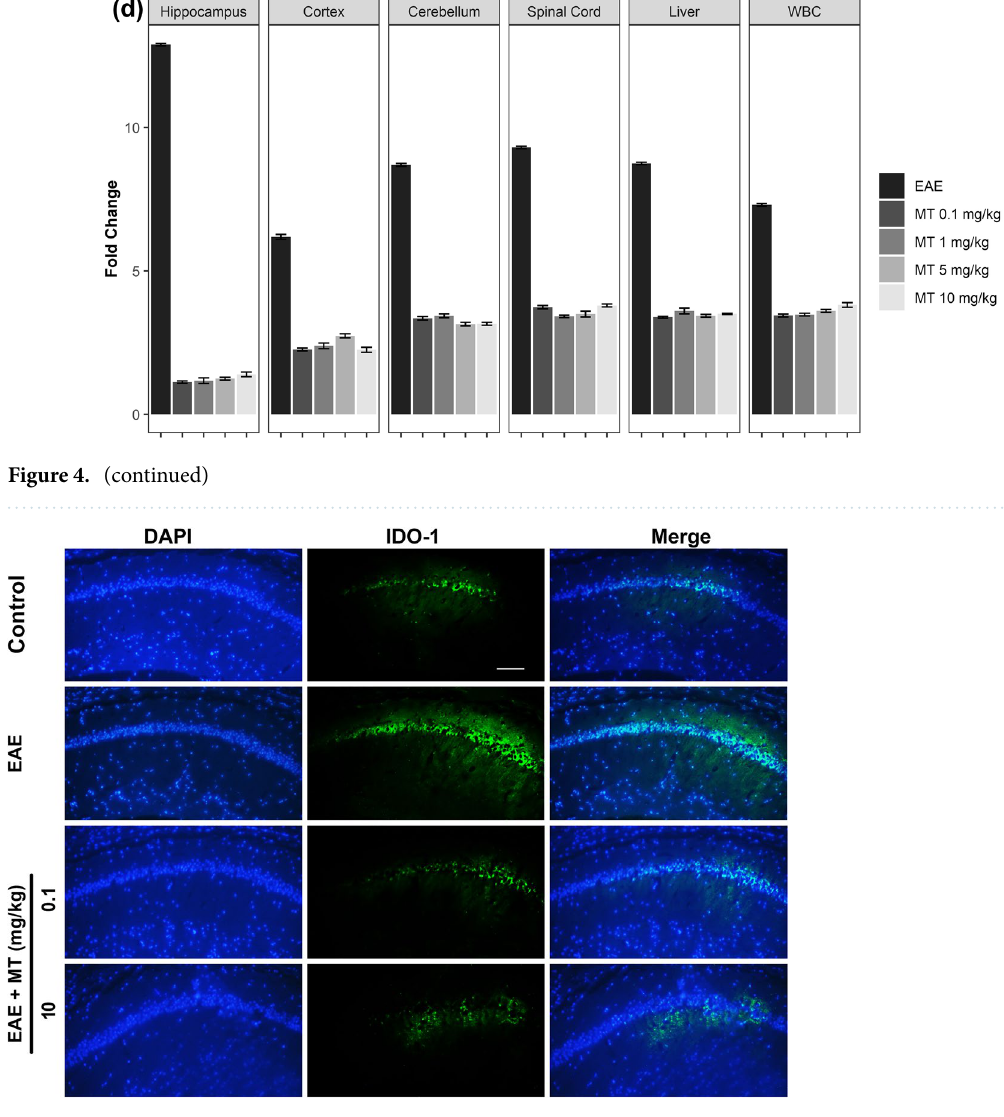
Figure 5. Effects of melatonin on IDO-1 protein expression in EAE mice. Representative images of Immunofluorescence staining showed that IDO-1 protein (green) is expressed in hippocampus area of EAE mice. The hippocampal structure is defined by fluorescent signal derived from DAPI positive cell nuclei (Blue). Scale bar, 25